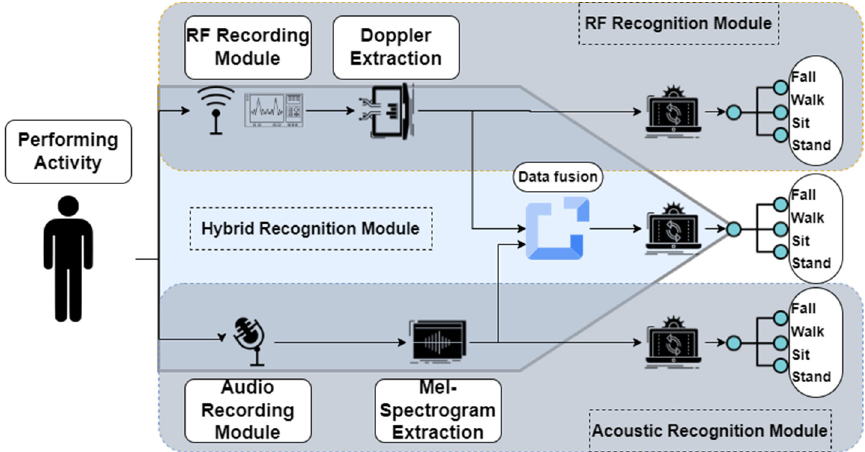
Figure 1. Proposed system overall